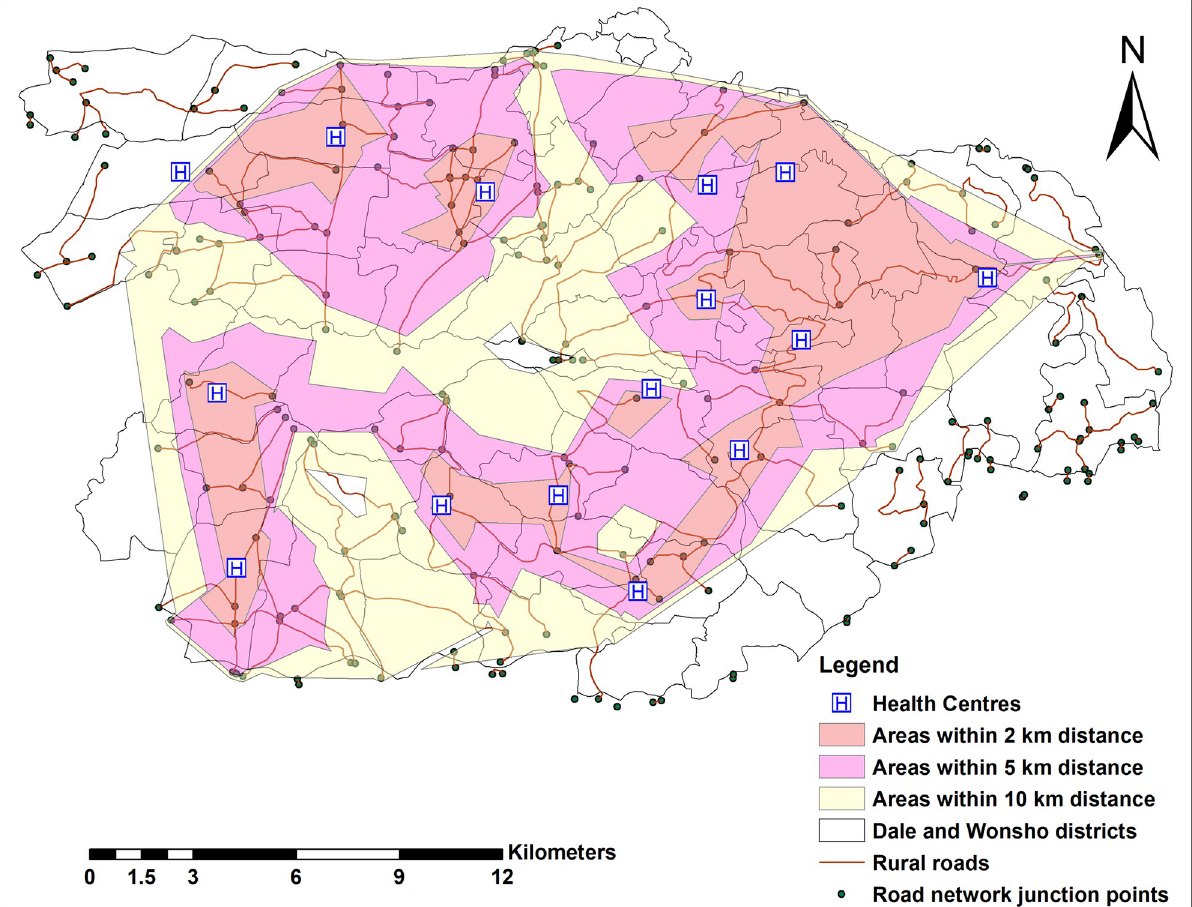
Fig 3. Distribution of health centres and distance of areas away from the health centres based on the road networks in Dale and Wonsho districts, Sidama, Ethiopia, 2017/18.